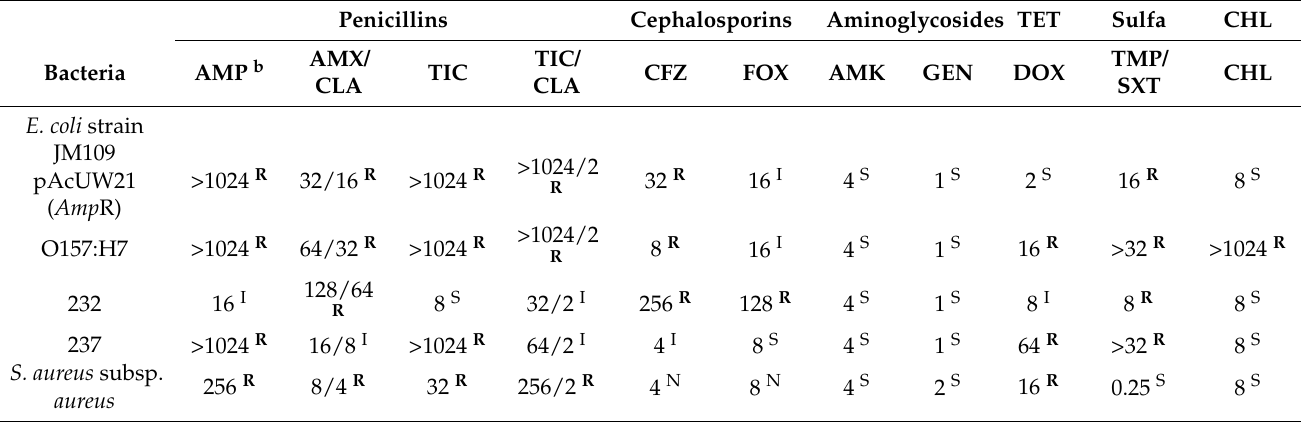
Table 2. Minimum inhibitory concentration a of antibiotics against Escherichia coli O157:H7, two clinical isolates, and Staphylococcus aureus subsp. aureus .